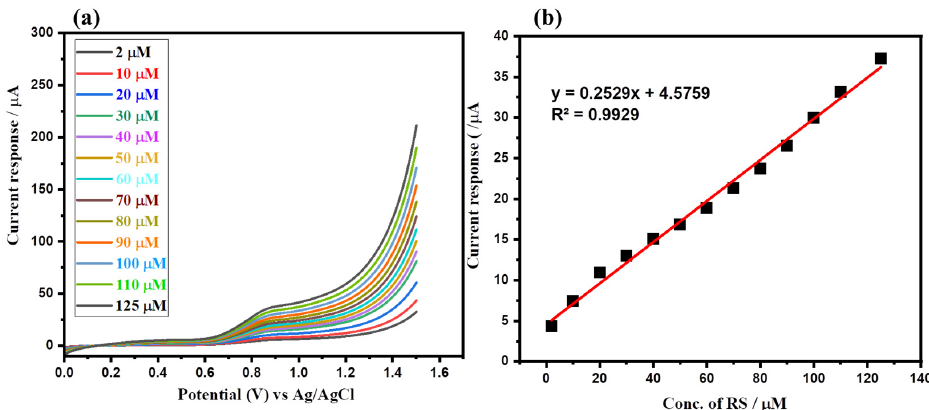
Figure 6. LSV responses ( a ) and calibration plot ( b ) of the MGC for 2–125 µM RS at a scan rate of 50